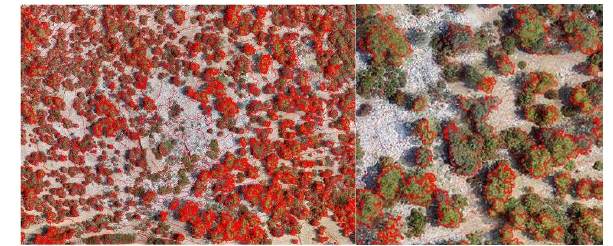
Figure 5: Kimisala site orthophotomosaic, with 1m contours